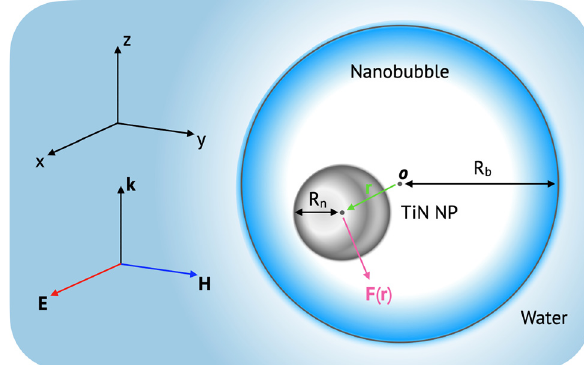
Figure 1: Schematic of optical configuration of a TiN NP in a nanobubble,whichisinthemediumofwater. F ( r )istheopticalforce ontheTiNNP,where r isthecenterofNP. k , E ,and H denotethewave vector, the electric fi eld, and the magnetic fi eld of an incident plane wave, respectively. R n is the radius of TiN NP; R b is the radius of nanobubble. o is the origin of the Cartesian coordinate